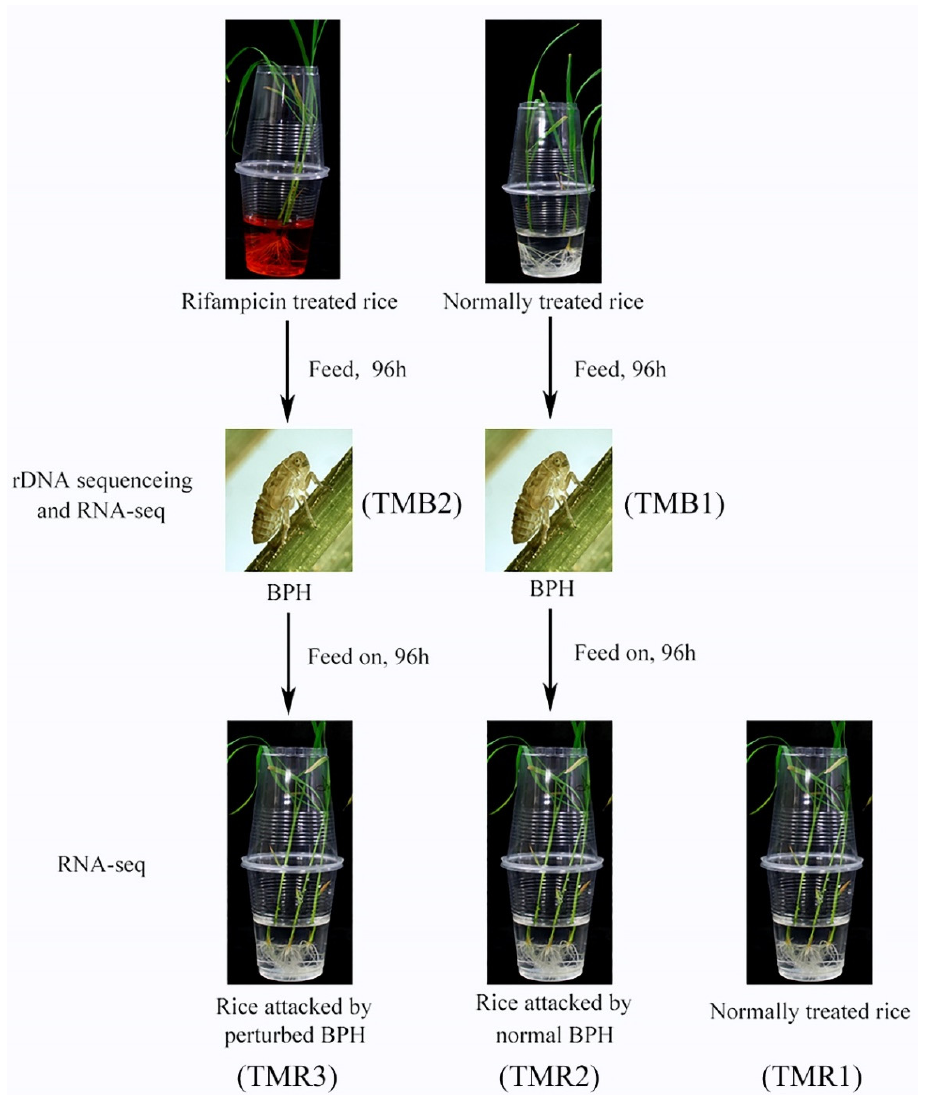
Figure 1. Perturbation of bacterial communities of BPH. Rice was treated with/without rifampicin before BPH feeding. The rifampicin will change the composition of the bacterial communities of BPH, which consequently affects BPH transcriptome. In turn, the change in BPH will also affect the rice being fed by BPH. To examine the effect of the changes of bacterial communities, we sequenced the 16S rRNA of the bacterial communities to confirm the perturbation result and used RNA-seq to assess the transcriptome of BPH and rice. In parentheses are the sample names of RNA-seq